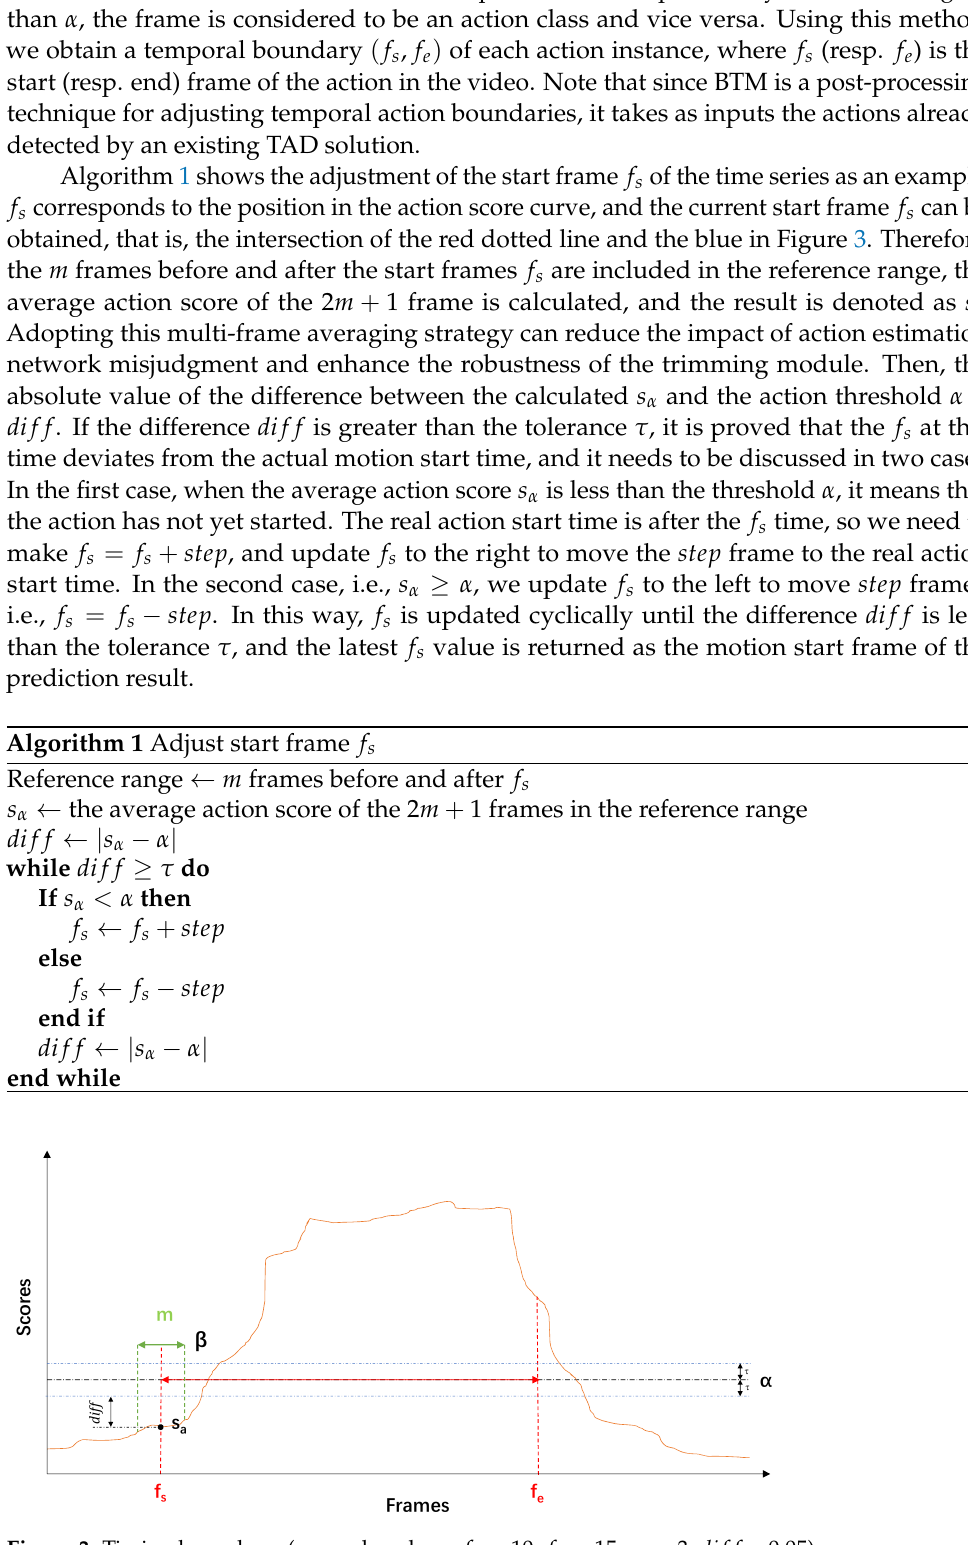
Figure 3. Timing boundary (example values: f s = 10, f e = 15, m = 3, dif f =